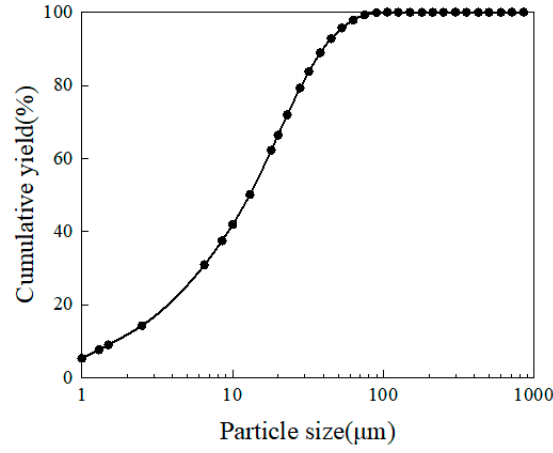
Figure 9. Particle size distribution of coal gasification fine slag after grinding.